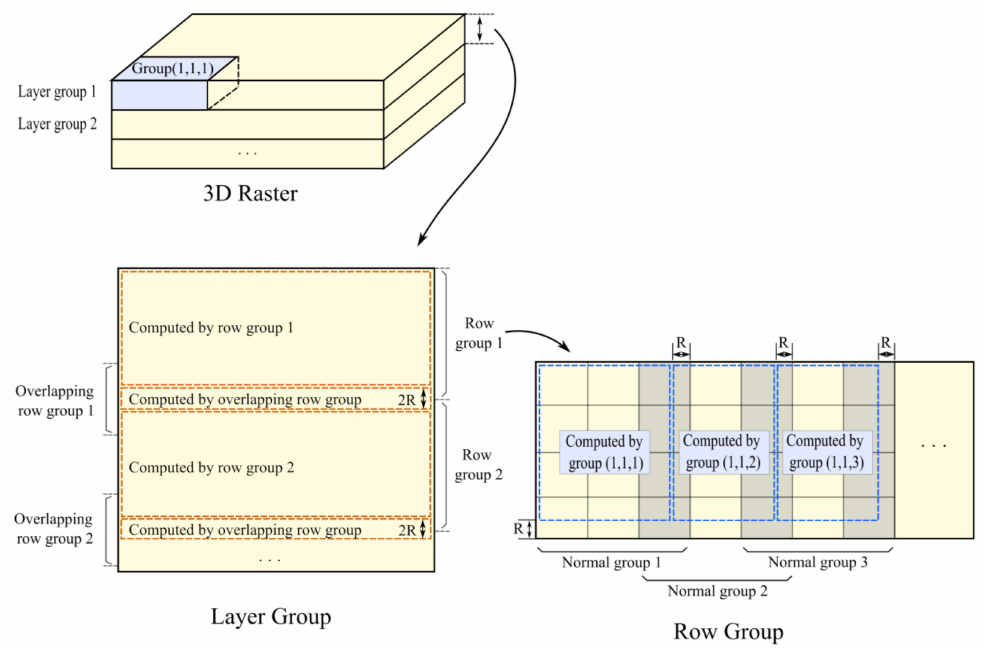
Figure 4. Assignment of analysis region for every group based on optimized data placement. In row groups, each normal group is responsible for the region that can be analyzed within the group data. For each layer group, regions that are not allocated by the normal groups are assigned to the overlapping row